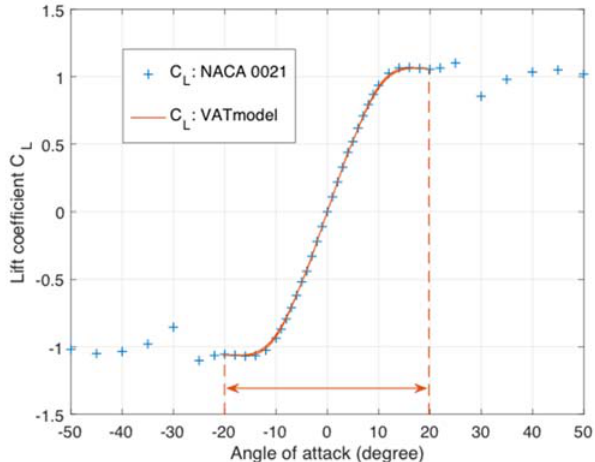
Figure 8. Lift coefficient as a function of local angle of attack at each grid point predicted by the VAT model for TSR = 2.9, compared with measurements for a static airfoil [76]; the red dashed lines show the range of local angle of attack.